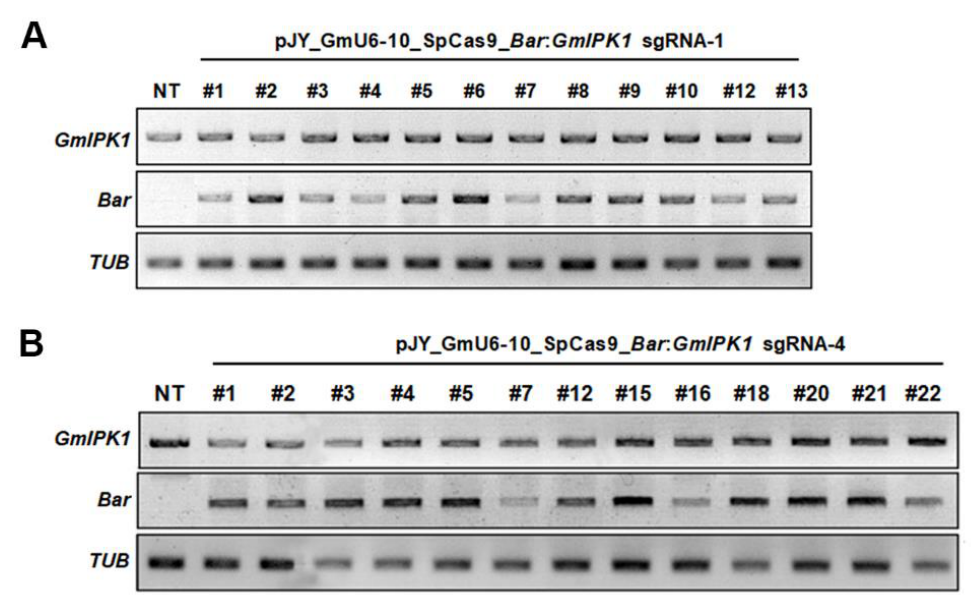
Figure 5. Analysis of transcript levels of introduced genes in Gmipk1 gene-edited soybean plants (T 0 ) using RT-PCR. Total RNA was extracted from GmIPK1 sgRNA-1 and GmIPK1 sgRNA-4 transgenic soybean plants (T 0 ), and RT-PCR was used to confirm the transgene expression. GmTUB gene was used as a quantitative control: NT, nontransgenic plant; ( A ) GmIPK1 sgRNA-1 transgenic lines (#1-#10, #12, #13); ( B ) GmIPK1 sgRNA-4 transgenic lines (#1-#5, #7, #12, #15-#16, #18, #20-#22).